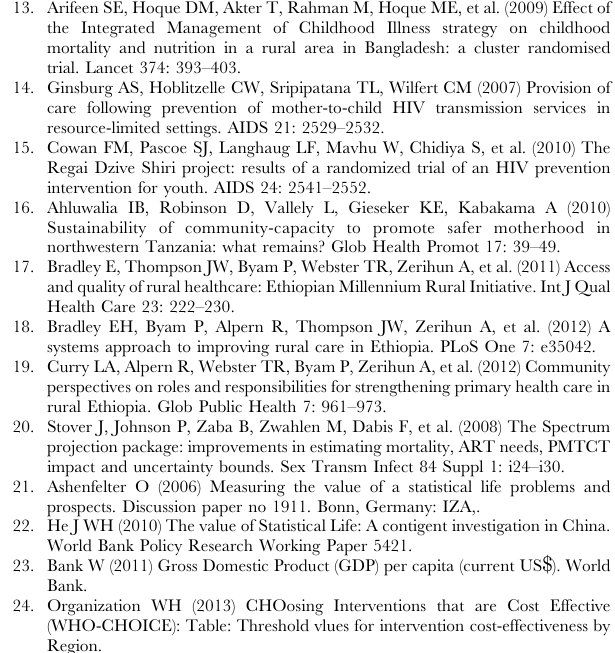
24. Organization WH (2013) CHOosing Interventions that are Cost Effective (WHO-CHOICE): Table: Threshold vlues for intervention cost-effectiveness by